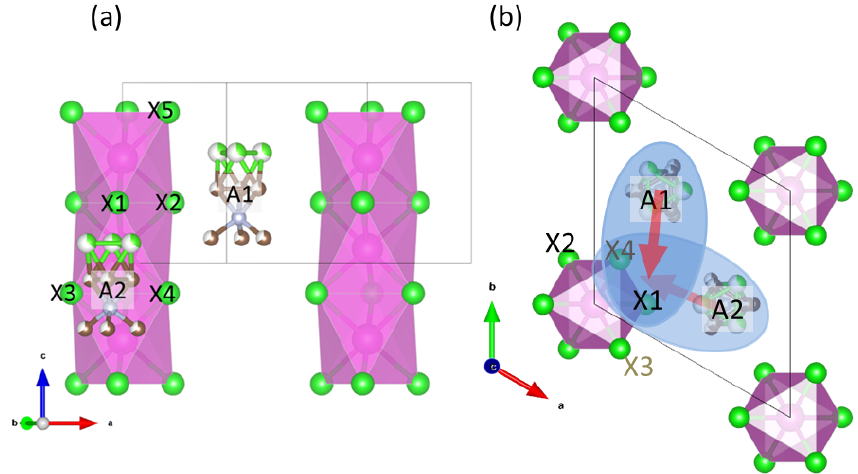
Figure 12. Geometry of the pair of TMCM and Cl vacancies. ( a ) Side view of a TMCM vacancy in A1, with the Cl vacancy preferentially occupying its nearest neighbour X1 and X2 sites; after a jump of the TMCM vacancy to A2, the Cl vacancy will visit preferentially the X3 and X4 sites. ( b ) Top view with representation of the electric and elastic dipoles associated with vacancy pairs in A1 and X1 and in A2 and X4.